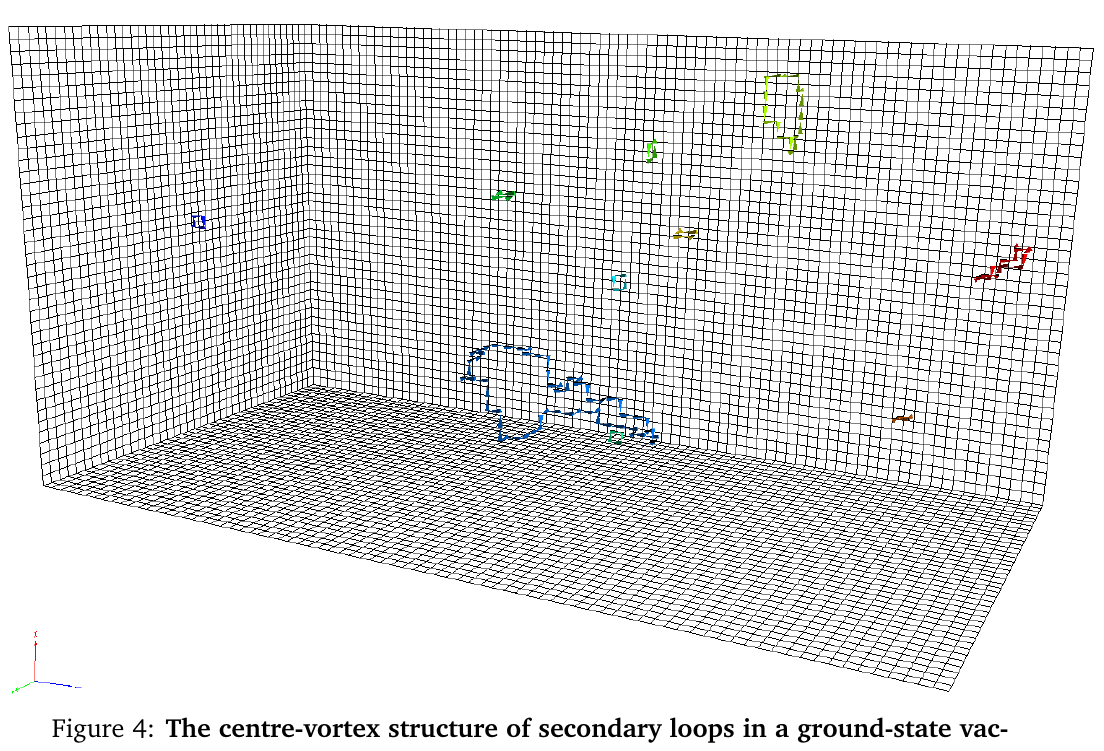
Figure 4: The centre-vortex structure of secondary loops in a ground-state vac- uum field configuration of pure SU(3) gauge theory. ( Click to activate. ) The flow of + 1 centre charge in the secondary loops – left behind as the single percolating structure is removed – is illustrated.